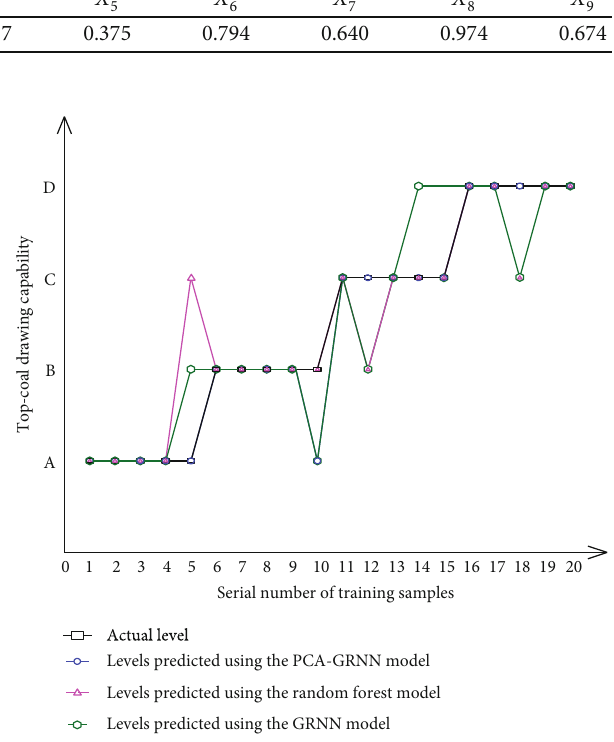
Figure 4: Comparison of levels predicted using the GRNN model, the random forest model, and the PCA – GRNN model. Table 6: Performance test results of each model.